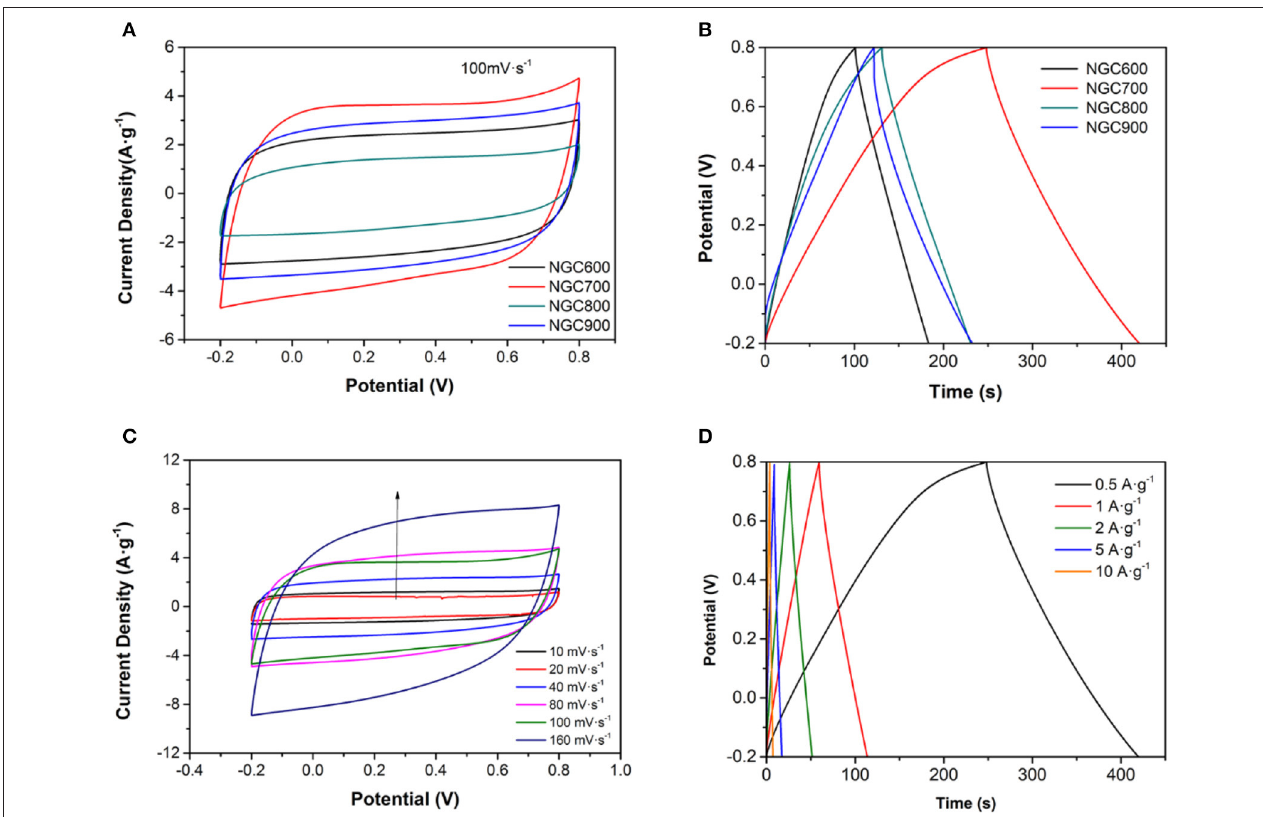
FIGURE 6 | (A) CV curves of NGC at the scan rates of 100 mV · s − 1 (B) CP curves of NGC at a current density of 0.5 A · g − 1 . (C) CV curves of NGC700 at different scan rates. (D) CP curves of NGC700 at various current densities.